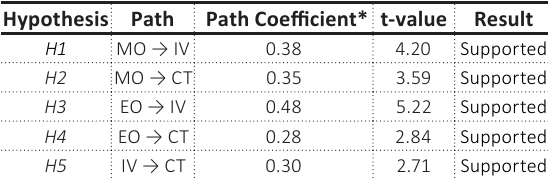
Table 5. Hypotheses testing results